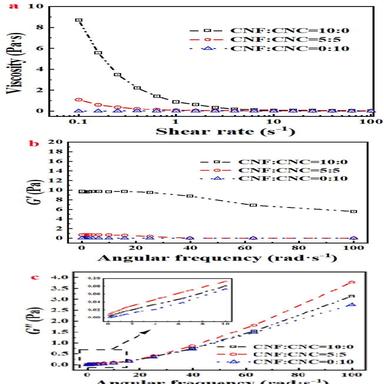
(a) Viscosity of nanocomposite suspensions with different ratios of CNF/CNC at various shear rates; (b) Storage modulus G′ and (c) loss modulus G′′ of nanocomposite suspensions with different ratios of CNF/CNC at various angular frequencies.